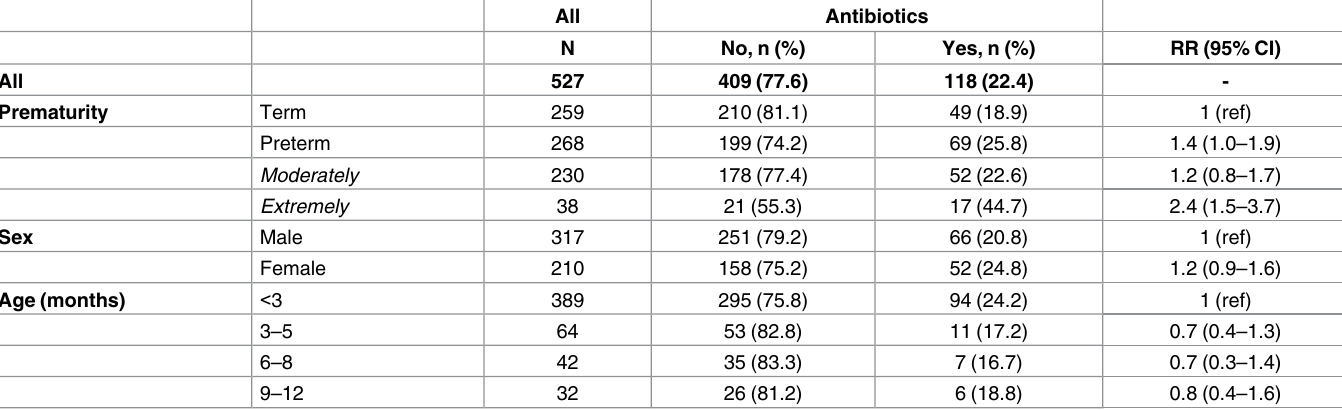
Table 2. Risk ratios (RR) and 95% confidence intervals (CI) for antibiotic treatment by prematurity, sex and age in infants 0–12 months of